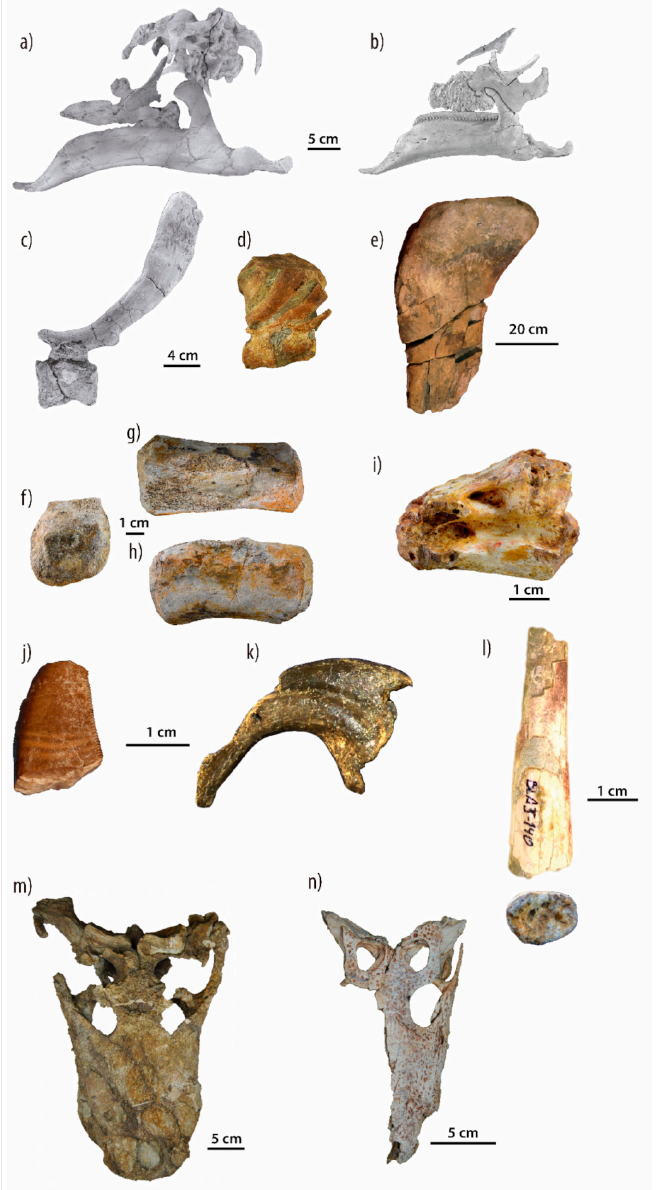
Figure 4. Main tetrapod remains from the Western Tremp Syncline. ( a ) Cranial elements of Arenysaurus ardevoli (MPZ2008/17, MPZ2008/256, MPZ2008/258, MPZ2008/259, MPZ2011/01), in left lateral view (modified from Cruzado- Caballero et al., 2013); ( b ) cranial elements of Blasisaurus canudoi (MPZ 99/664, MPZ 99/665, MPZ99/666a, MPZ99/666b, MPZ99/667, MPZ 2009/348), in left lateral view; ( c ) mid-caudal vertebra of Arenysaurus (MPZ204/480), in left lateral view (modified from Cruzado-Caballero et al., 2013); ( d ) articulated mid-caudal vertebrae of the small hadrosaurid from Serraduy (MPZ 2013-371), in left lateral view; ( e ) femur (proximal end) of Titanosauria indet. from Serraduy (MPZ 99/143), in posterior view (modified from Pu é rtolas-Pascual et al., 2018); ( f – h ) posterior caudal vertebra of Titanosauria indet. (MPZ2021/1), in anterior view ( f ); dorsal view ( g ); left lateral view ( h ); ( i ) cervical vertebra of Ornithuromorpha indet. (MPZ 2019/264), in left lateral view; ( j ) cf. Arcovenator tooth (MPZ 2017/804), in lingual view; ( k ) pedal ungual II of Dromaeosauridae indet. (MPZ 2019/196), in lateral view; ( l ) fragmentary bone of Pterosauria indet. (MPZ 2021/54) (note the thin cortex in the transverse section); ( m ) skull of Agaresuchus subjuniperus (MPZ 2012/288), in dorsal view; ( n ) skull of Arenysuchus gascabadiolorum (MP Z2011/184), in dorsal